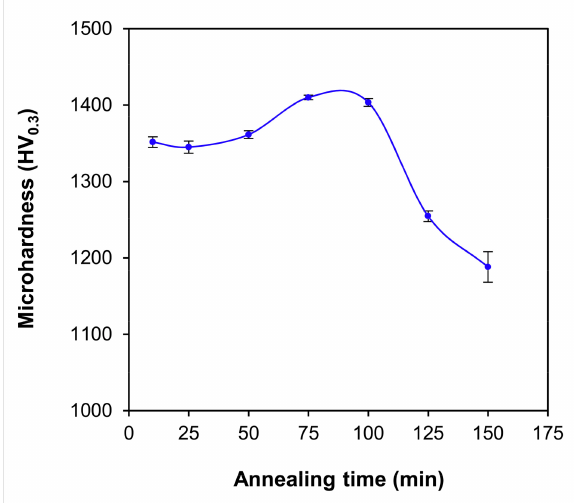
Figure 5. Microhardness of the samples annealed at 1025 K.